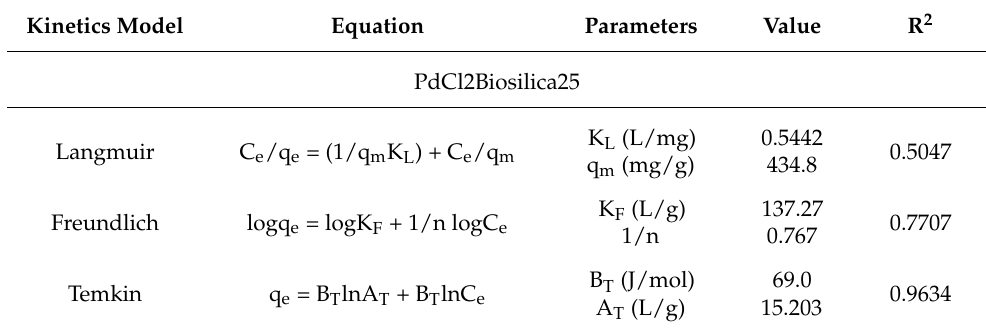
Table 2. The parameters of the MO photocatalytic degradation isotherm as determined from fitted isotherm models: C e (mg/L) is the equilibrium concentration, q m (mg/g) the maximum adsorption capacity, K L (L/mg) the Langmuir constants, K F (L/g) and 1/n are the Freundlich constants, BT is a constant related to the heat of adsorption and defined by the expression BT = RT/b, b is the Temkin constant (J/mol), A T is the Temkin isotherm constant (L/g), T is the absolute temperature (K), and R is the gas constant (8.314 J/mol